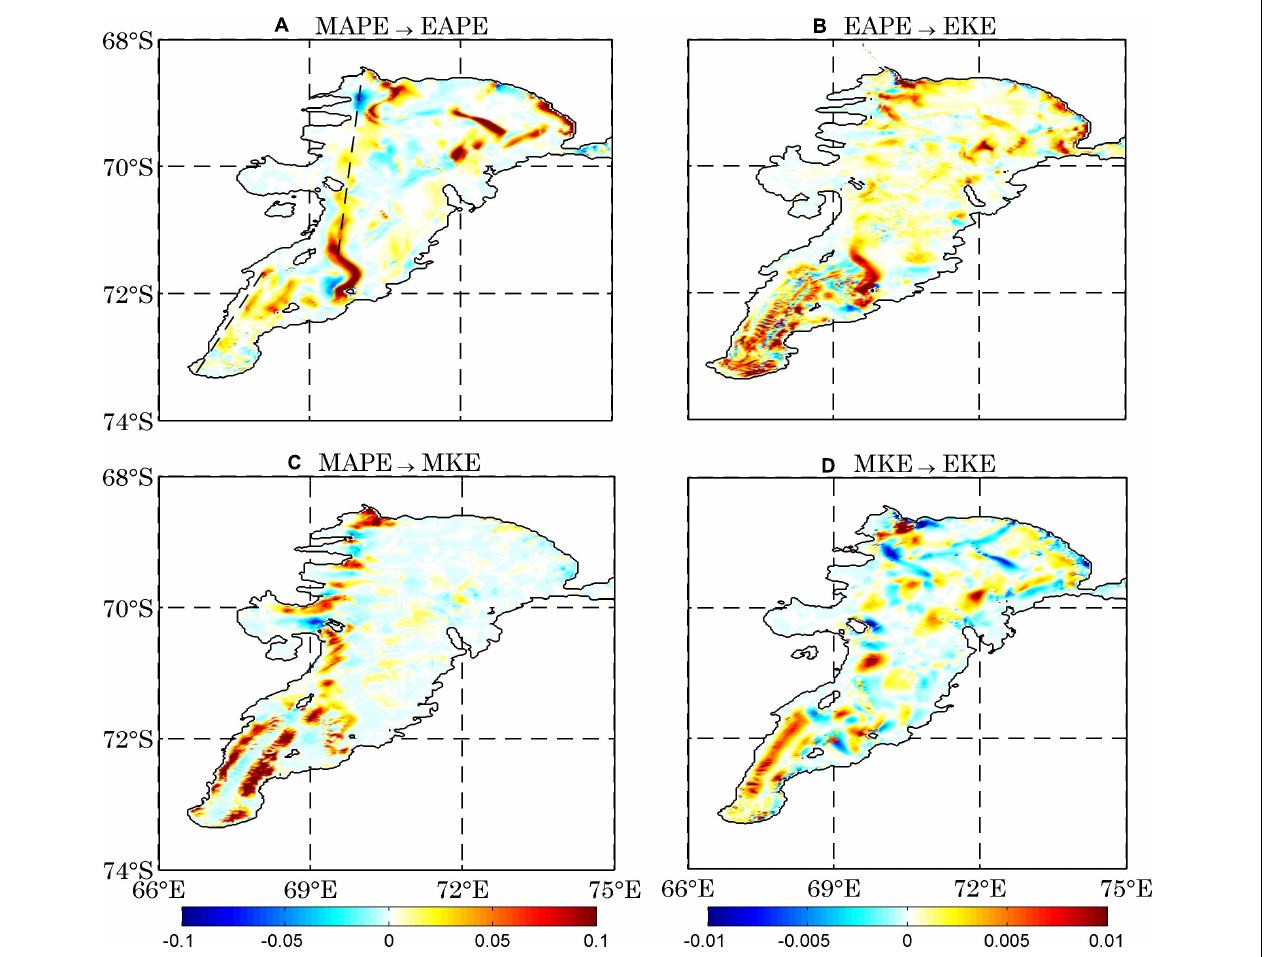
FIGURE 8 | The annual mean distributions of vertically integrated conversion rates between MAPE and EAPE (1 × 10 − 1 W m − 2 ) (A) , EAPE and EKE (W m − 2 ) (B) , MAPE and MKE (W m − 2 ) (C) , and MKE and EKE (W m − 2 ) (D) . The positive (negative) value means energy is transferred from MAPE to EAPE (EAPE to MAPE).